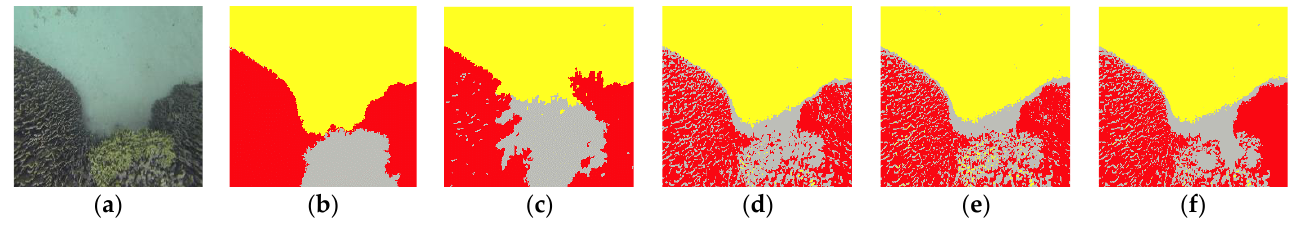
Figure 18. Validation tests of the proposed segmentation algorithms using highly illuminated and low contrast blue coral image (10) from Figure 15 as example of three categories: ( a ) original image; ( b ) ground truth image; ( c ) FF result; ( d ) FR result; ( e ) OS result; ( f ) KM result. Red: blue corals, gray: corals, and yellow: sediments.